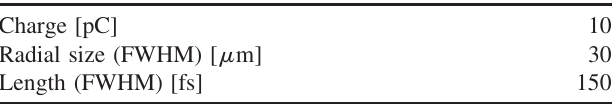
TABLE I. General parameters of injected electron bunches.